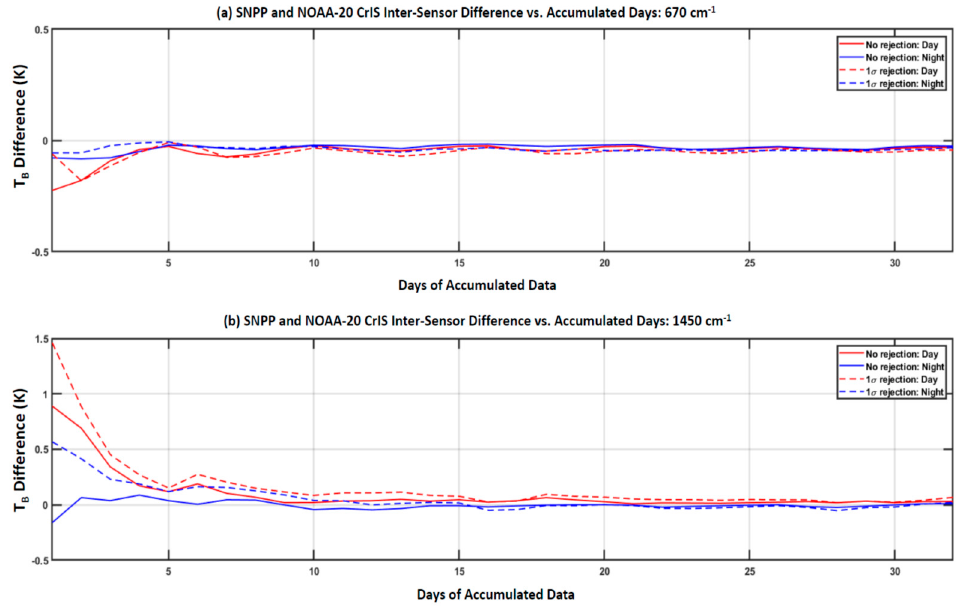
Figure 18. Time series of the globally-averaged brightness temperature differences at two CrIS channels of 670 and 1450 cm − 1 between SNPP and NOAA-20 CrIS, which are calculated using the datasets from one to 32 days with the one-sigma threshold applied to the datasets per each time period. ( a ) 670 cm − 1 . ( b ) 1450 cm − 1 .